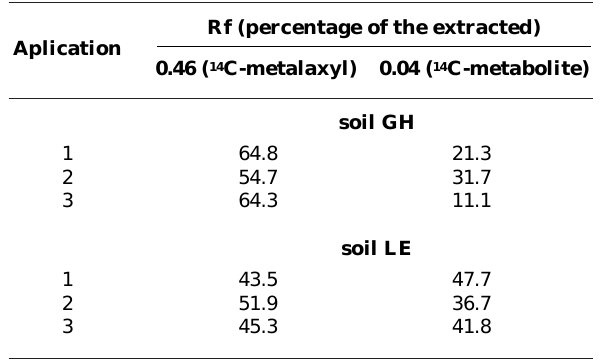
Table 2. Recovery of 14 C-extractable residues by thin-layer chromatography of soils treated with 14